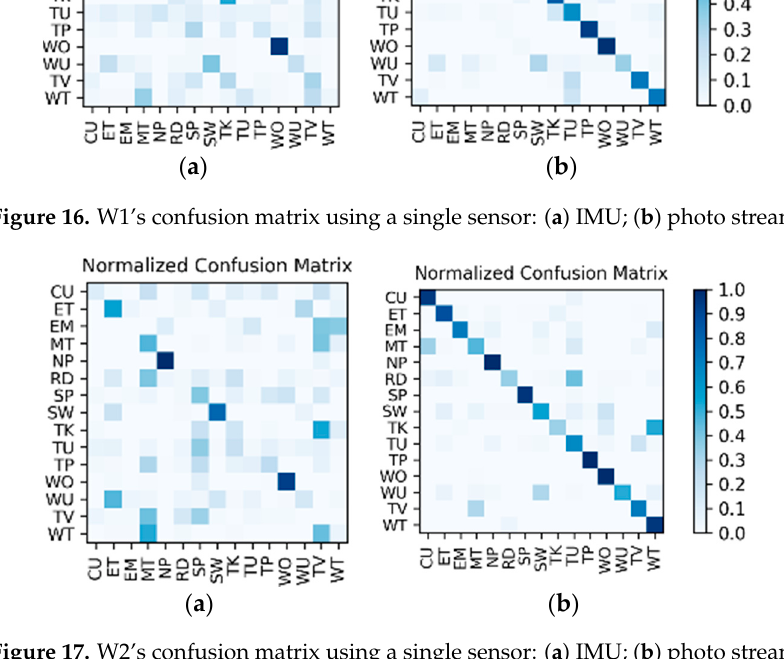
Figure 17. W2’s confusion matrix using a single sensor: ( a ) IMU; ( b ) photo stream.